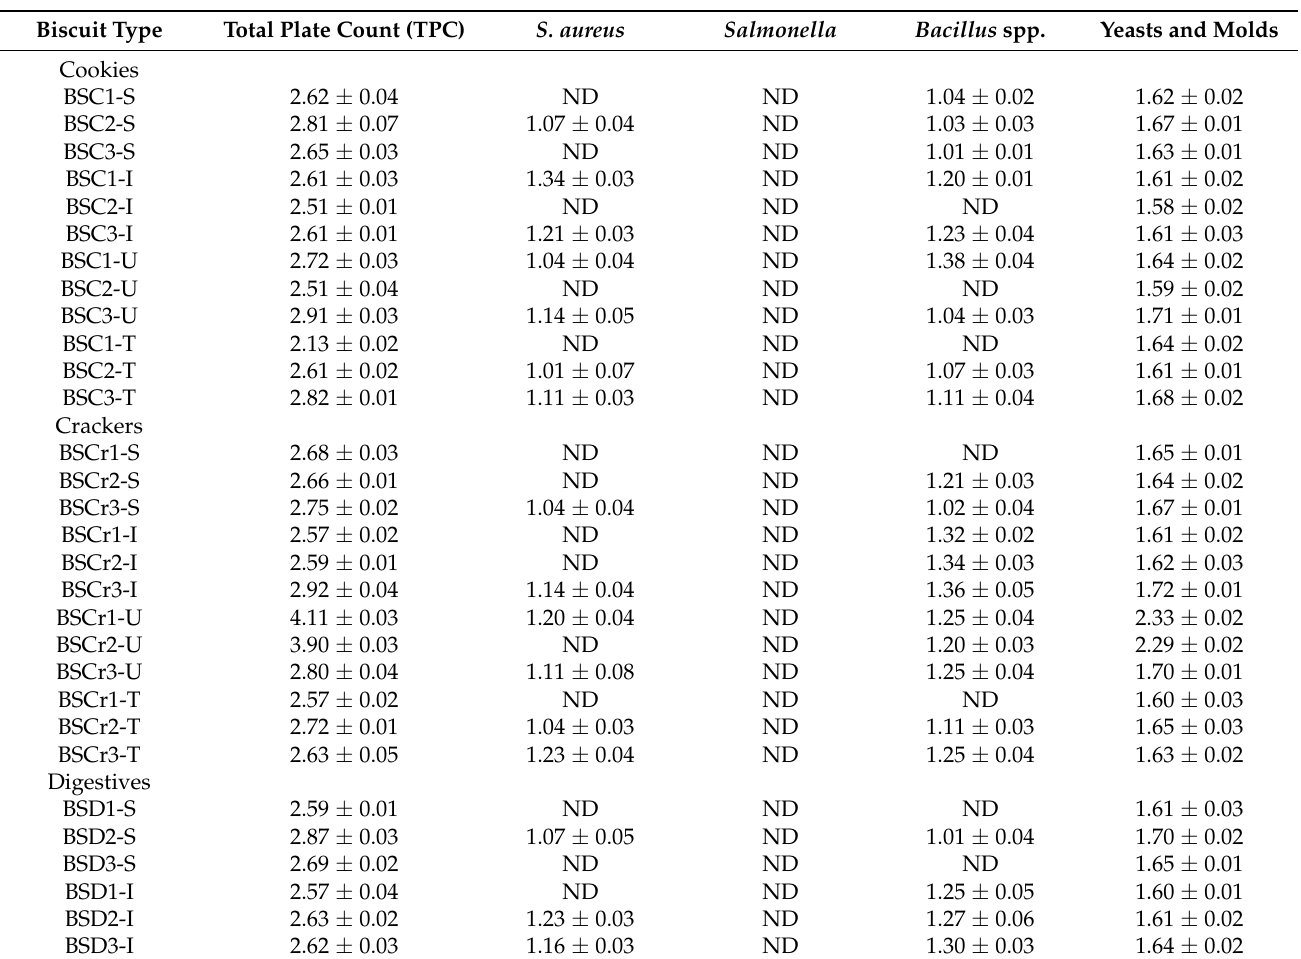
Table 5. Microbial load (log cfu/g) of biscuits marketed in Basrah,